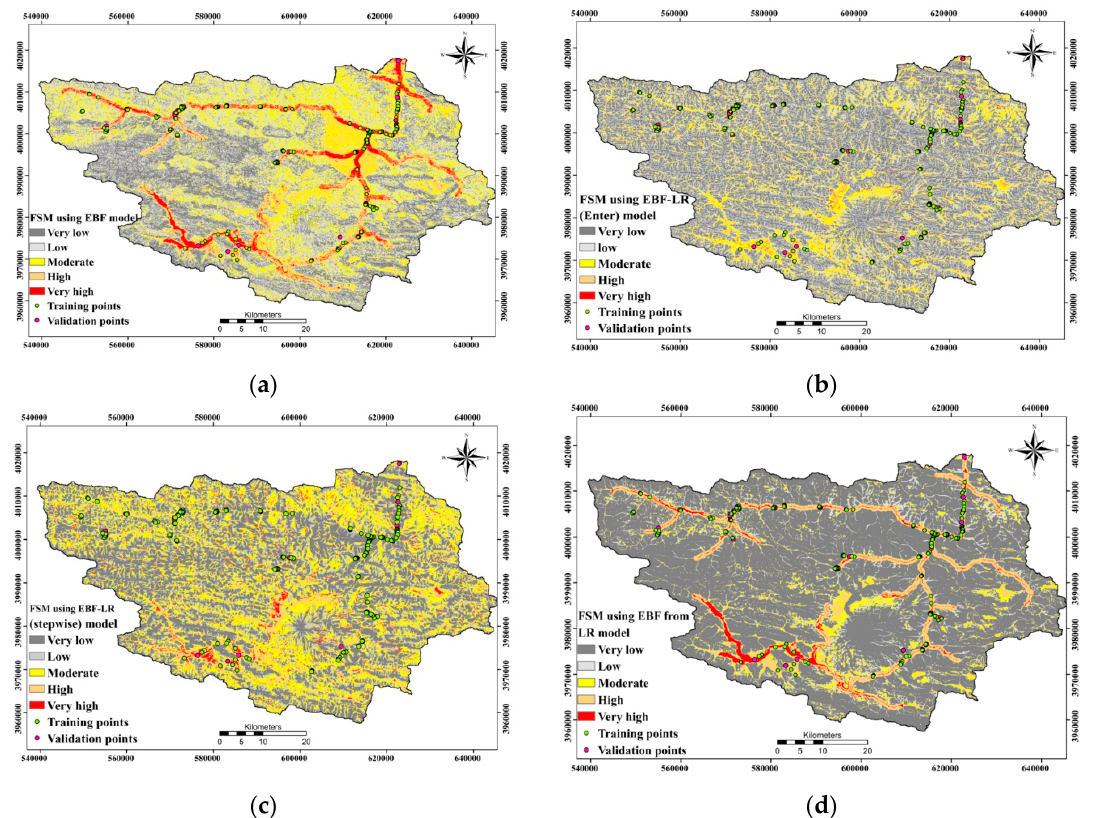
Figure 6. Flood Susceptibility Index using ( a ) EBF, ( b ) EBF-LR (Enter), ( c ) EBF-LR (Stepwise), ( d ) EBF from LR. Table 6. LR model